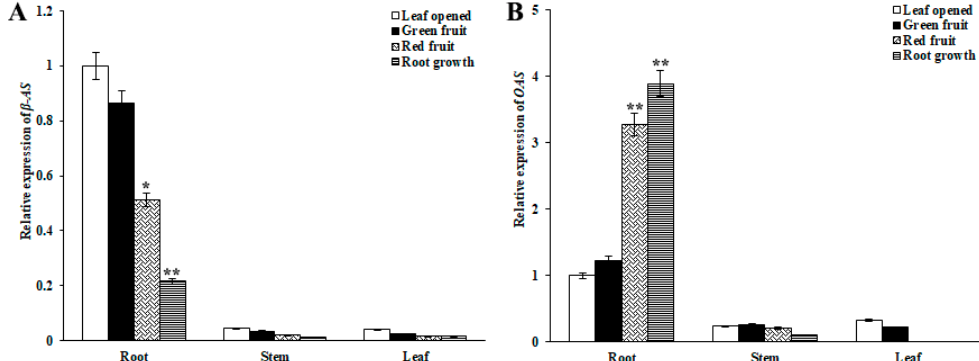
Figure 8. Expression of genes related to ginsenoside biosynthesis in roots, stems, and leaves during different growth times. The relative expression of ( A ) β -AS and ( B ) OAS genes in the leaf opened, green fruit, red fruit, and root growth stages was analyzed by real-time polymerase chain reaction. Vertical bars indicate the mean ± standard error from three independent experiments. * indicated that the different growth stages are significantly different at the 0.05 level. ** indicated that the different growth stages are significantly different at the 0.01 level.